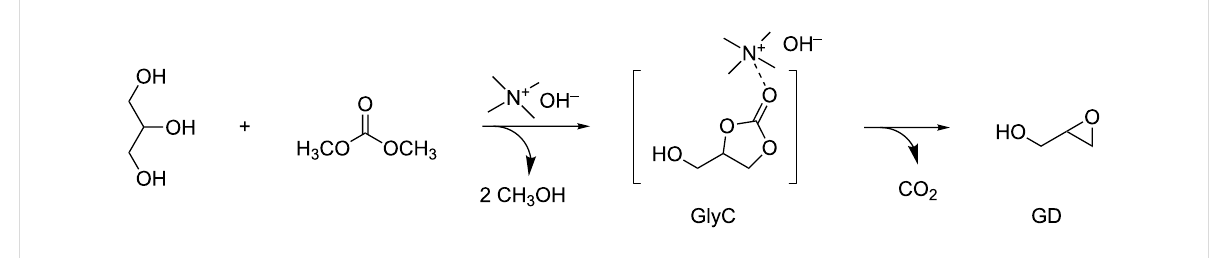
Scheme 14: Cooperative mechanism of ionic liquid-catalyzed glycidol